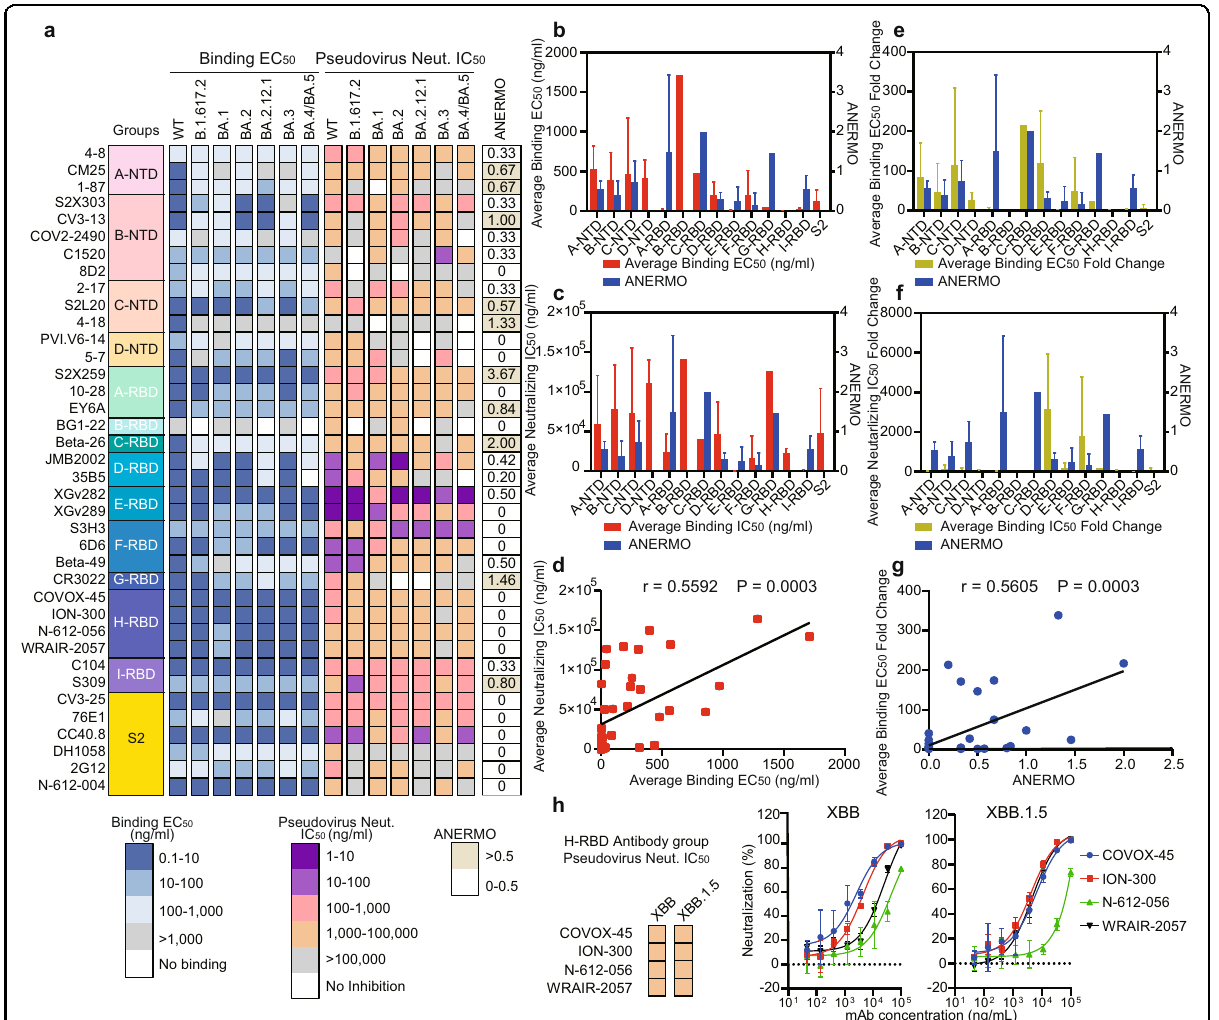
Fig. 3 Binding and neutralization activities of the potential broad-spectrum antibodies. a Heatmap showing the binding EC 50 against S fragments of SARS-CoV-2 variants and neutralization IC 50 of pseudotyped SARS-CoV-2 variants. b The average binding EC 50 against the WT, Delta, and the fi ve indicated Omicron variants, and the average number of epitope residues mutated in Omicron (ANERMO) of different classes of antibodies. c The average neutralization IC 50 against the WT, Delta, and the fi ve indicated Omicron variants, and the ANERMO of different classes of antibodies. d The Pearson correlation coef fi cients analysis between the average binding EC 50 and the average neutralization IC 50 values of the expressed antibodies. e The average binding EC 50 fold change between the fi ve indicated Omicron variants and WT, and the ANERMO of different classes of antibodies. f The average neutralization IC 50 fold change between the fi ve indicated Omicron variants and WT, and the ANERMO of different classes of antibodies. g The Pearson correlation coef fi cients analysis between the average binding EC 50 fold change and the ANERMO of the expressed antibodies. Samples were tested in triplicate. Data are shown as mean ± SD. h The neutralization activities of antibodies from H-RBD class against pseudotyped XBB and XBB.1.5